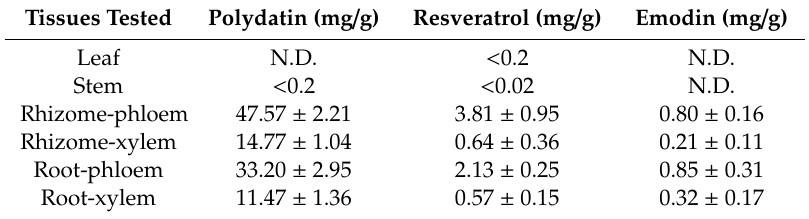
Table 1. Contents determination of polydatin, resveratrol and emodin in di ff erent tissues of R.japonica . Tissues